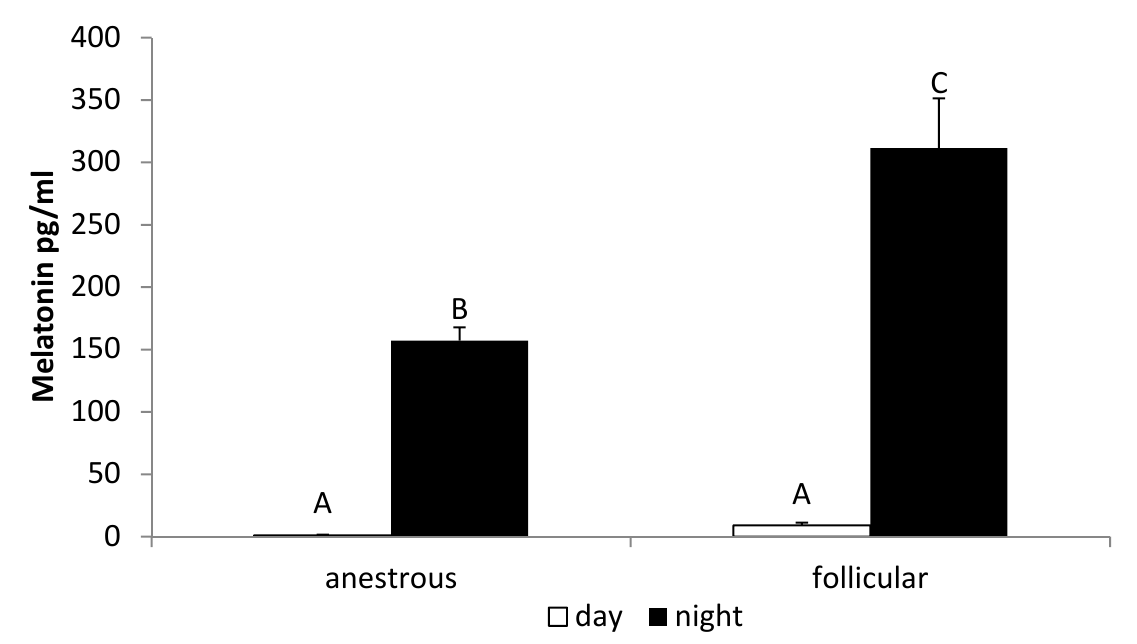
Figure 2. The day/night changes in the circulating level of melatonin in the anestrous and follicular phase ewes. All data are presented as the mean ( ± S.E.M.). Different capital letters indicate significant ( p < 0.05) differences according to a two-way ANOVA followed by NIR Fisher’s post-hoc